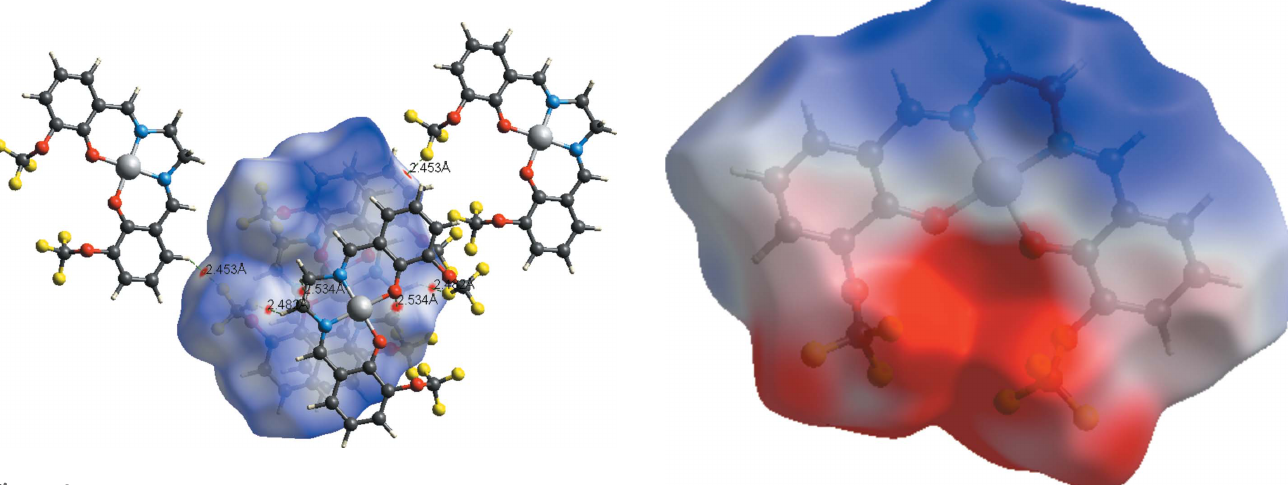
Figure 4 Hirshfeld surface mapped over d norm , showing the weak intermolecular C—H (cid:2)(cid:2)(cid:2) O and C—H (cid:2)(cid:2)(cid:2) F contacts.